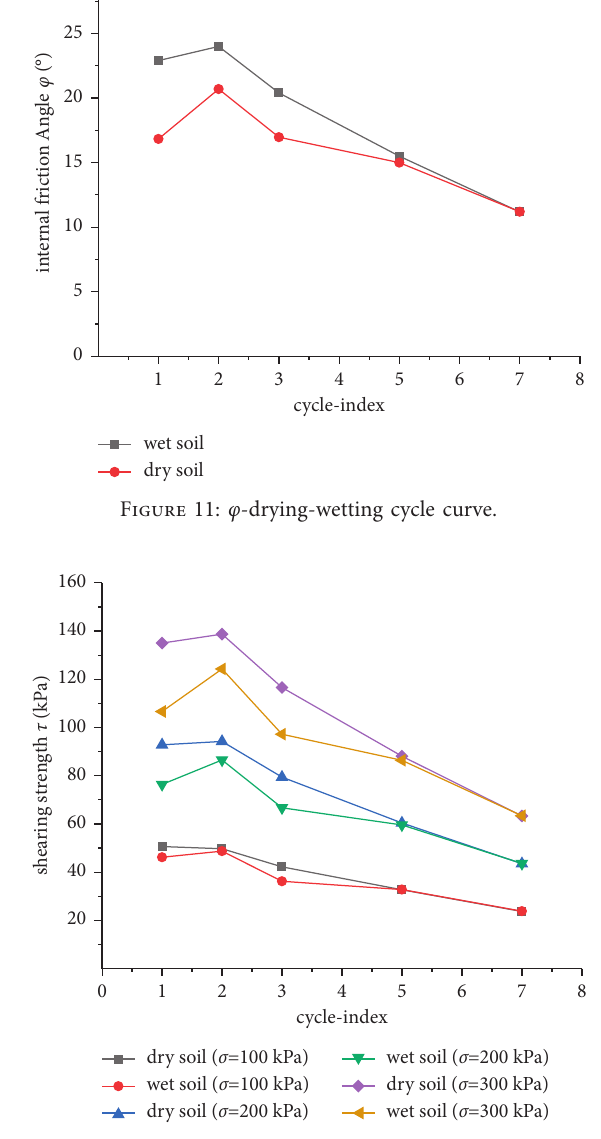
Figure 12: τ -drying-wetting cycle curves.